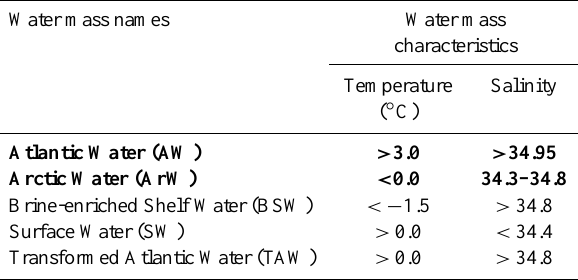
Table 1. Water mass characteristics in Storfjorden and Storfjor- drenna (Skogseth et al., 2005, modified). The two main water masses are in